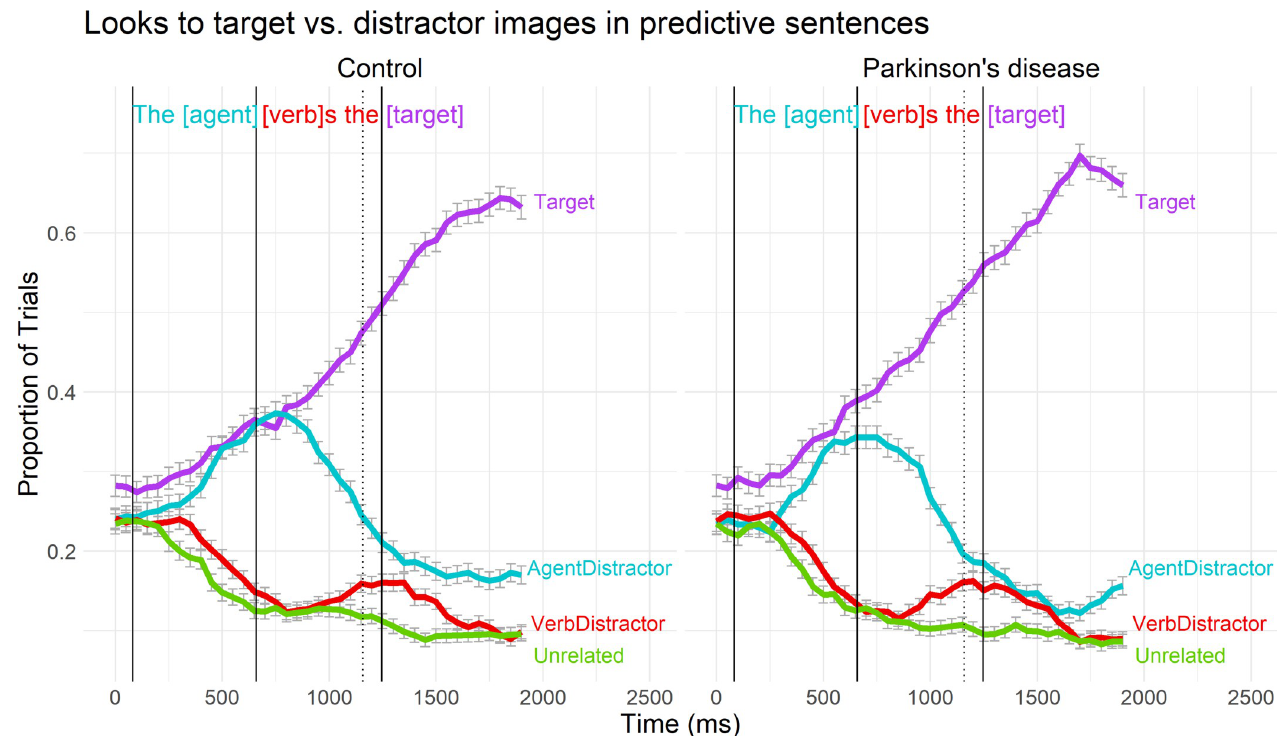
Fig 2. Gaze data by group in predictive sentences. Binned binomial gaze probabilities to each area of interest, averaged across subjects and trials over the duration of the predictive sentences for controls (left) and PD participants (right). The x-axis reflects the elapsed time in the trial in milliseconds, offset by 200ms to account for saccade programming/launching time. The solid vertical lines mark the onset of the agent, verb, and target words. The dotted vertical line marks the end of the verb statistical analysis window (which extends only partially into the post-verb article). Error bars represent standard error of the mean.